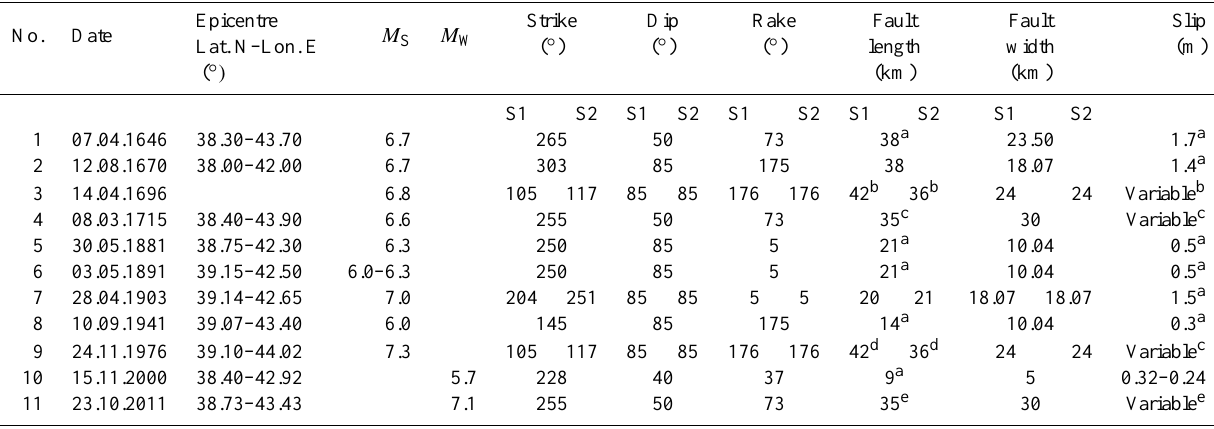
Table 4. Rupture parameters for the earthquakes selected for the Coulomb stress change modelling in the Lake Van area. S1 and S2 stand for first and second segment of the earthquake rupture under interest. See Fig. 2 for the epicentral distribution.